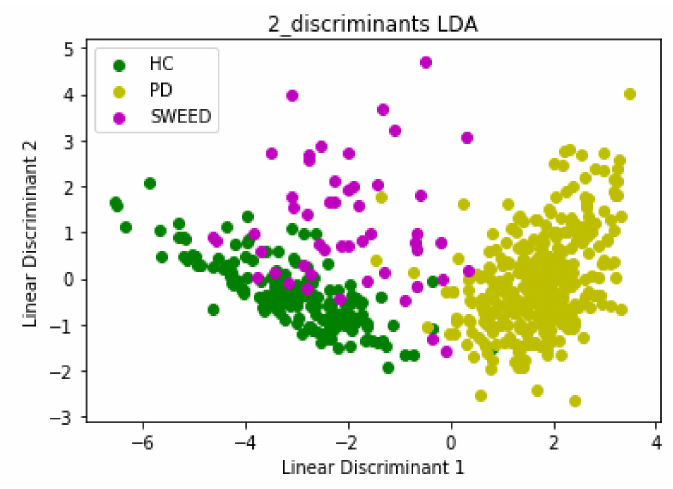
Figure 4. The new feature subspace constructed using LDA with class